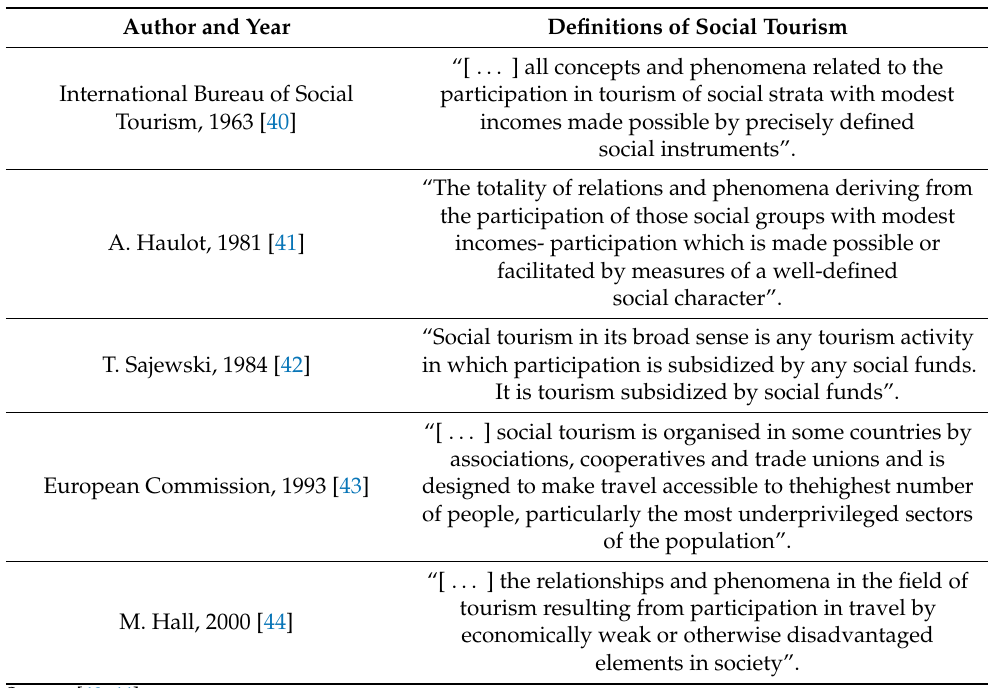
Table 3. Definitions of social tourism in the 20th century according to various authors and